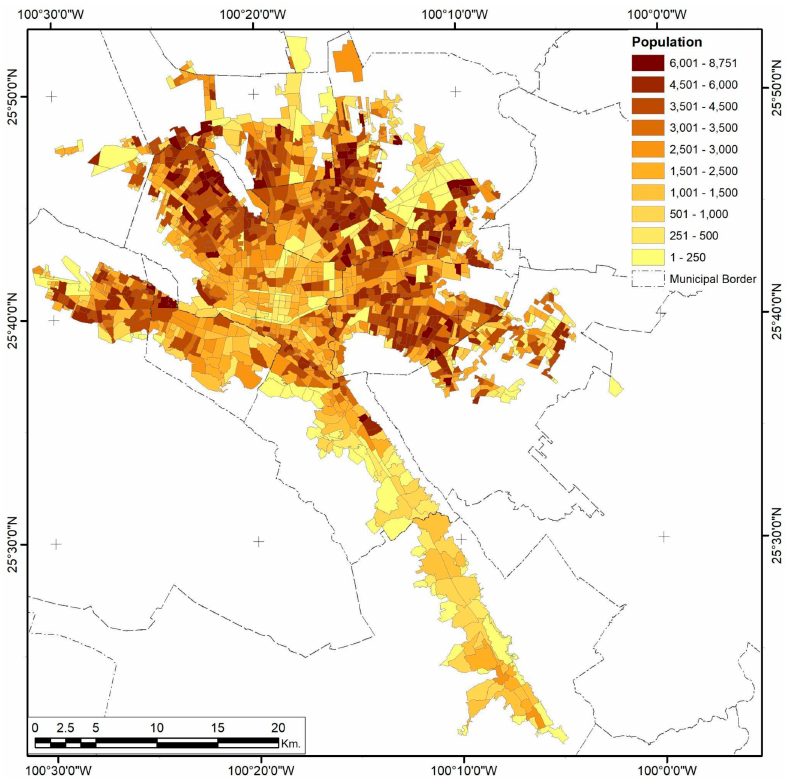
Figure 9. Monterrey City population density by AGEB. Developed by the authors with data from